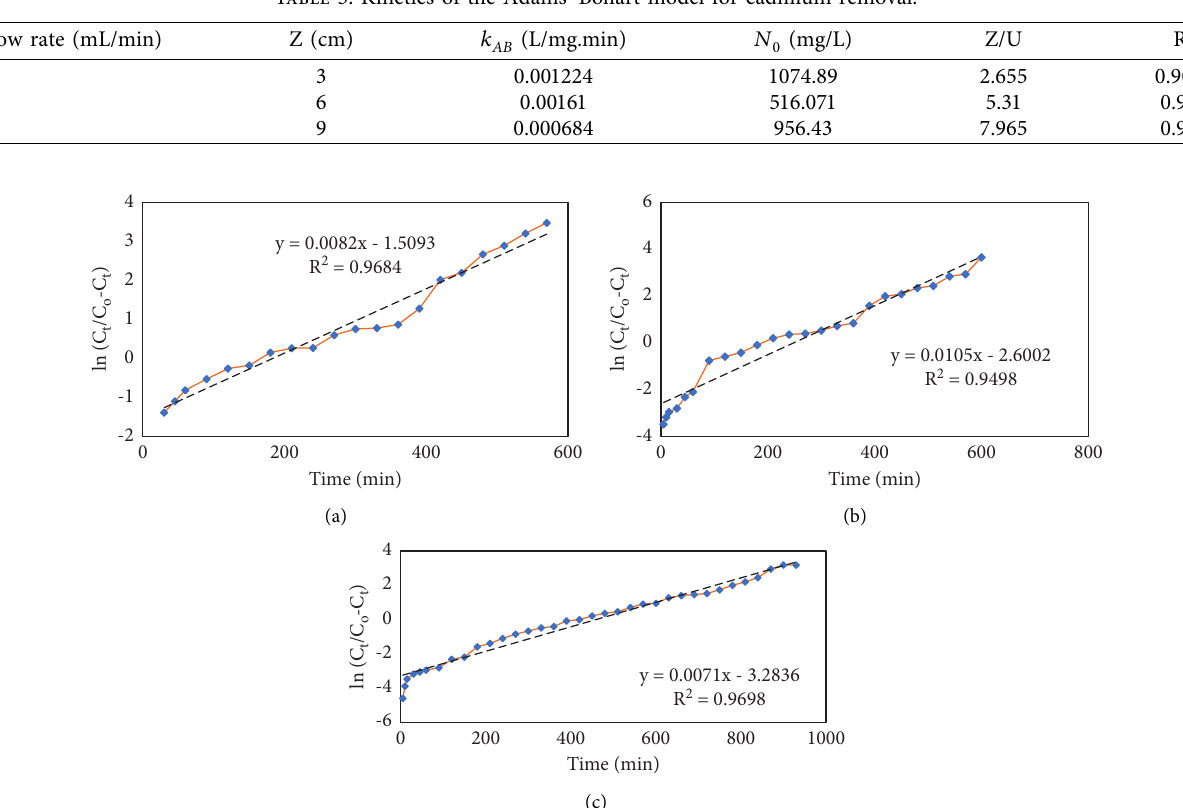
Figure 7: Yoon–Nelson plots for copper removal at different bed depths. (a) Bed depth of 3cm. (b) Bed depth of 6cm. (c) Bed depth of 9cm. Table 6: Yoon–Nelson parameters for copper removal. Flow rate